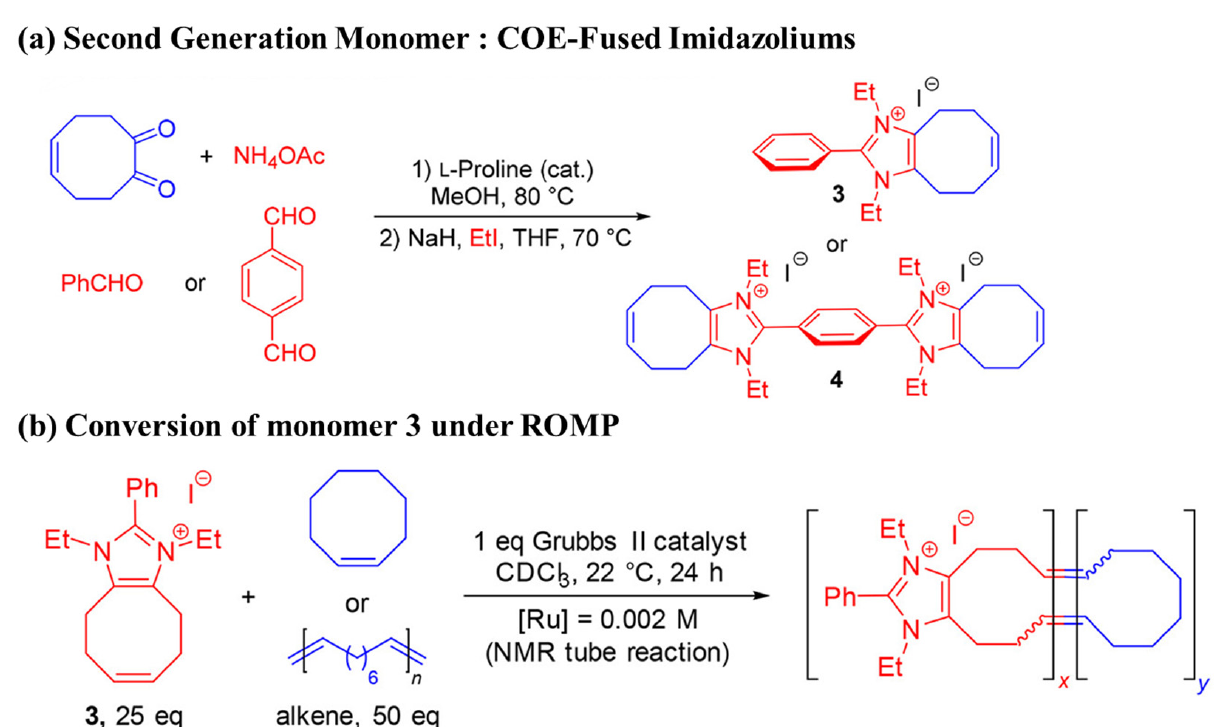
Figure 13. Synthesis of ( a ) imidazolium monomer 3; ( b ) polyolefin AEM materials (Reprinted with permission from ref. [174] Copyright 2018 American Chemical Society). Table 9. Ionic conductivity of polyolefin-based membranes. Thickness Conductivity Membrane Condition Ref. (µm) (mS/cm)